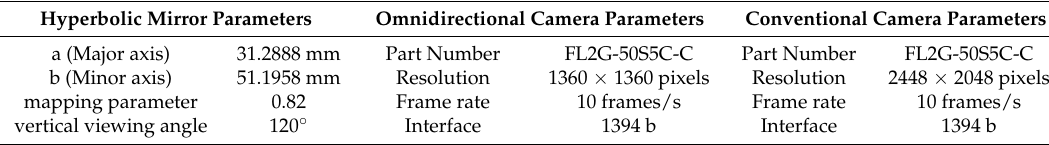
Figure 7. Experiment platform. The upper camera is omnidirectional, and the lower camera is conventional. Table 1. Camera parameters given by the manufacturer.